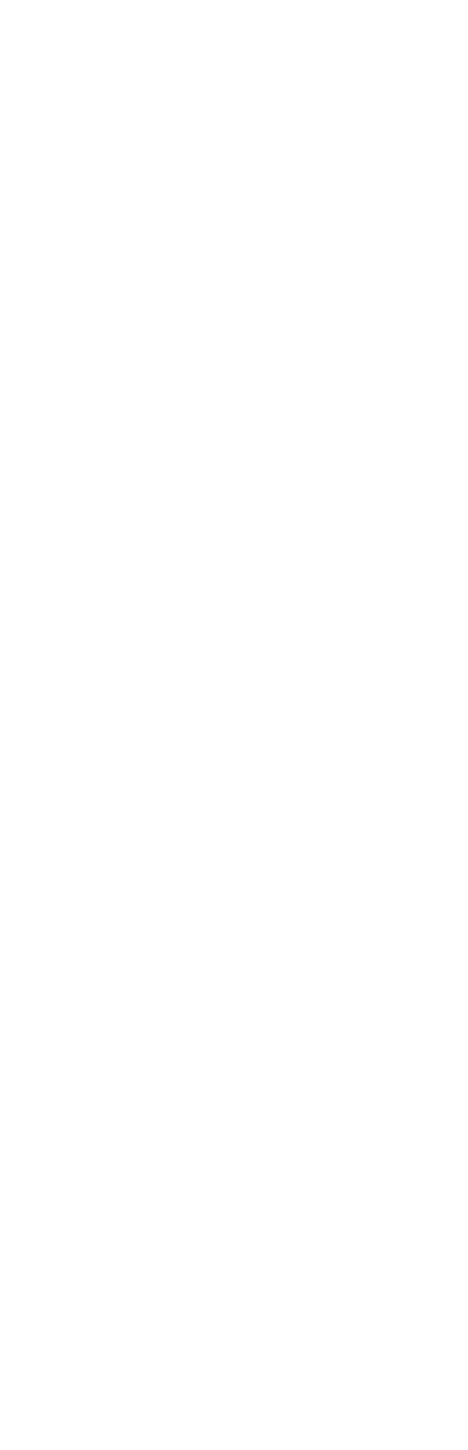
Figure 1. Schematic representation of the condenser type OIP (oil impregnated paper) bushings investigated in this paper.